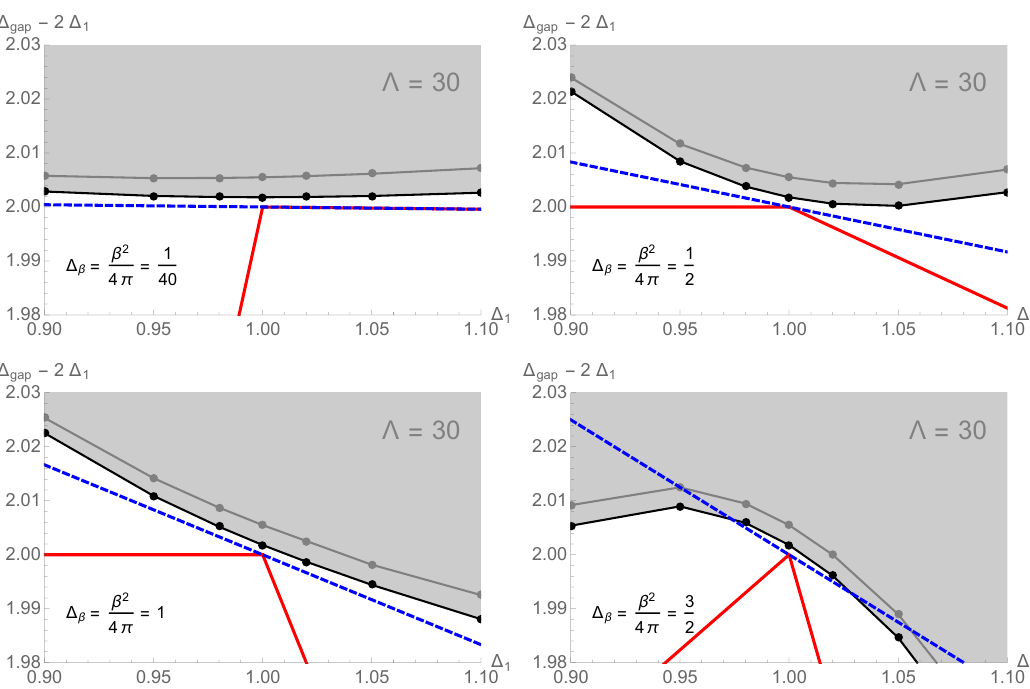
Figure 10 . Tracing the maximal gap along the lines given by the sine-Gordon theories with the given values of ∆ β . The gray bounds correspond to Λ = 20 and the black ones to Λ = 30 . The bound is always tangent to the blue lines corresponding to the deformed theory that is obtained by switching on an independent g 8 . The original sine-Gordon theories, in red, only saturate the numerical bound at the free point. Notice that the vertical axis shows ∆ gap − 2∆ 1 rather than just ∆ gap to more clearly show the small deviations from a straight line in the numerical